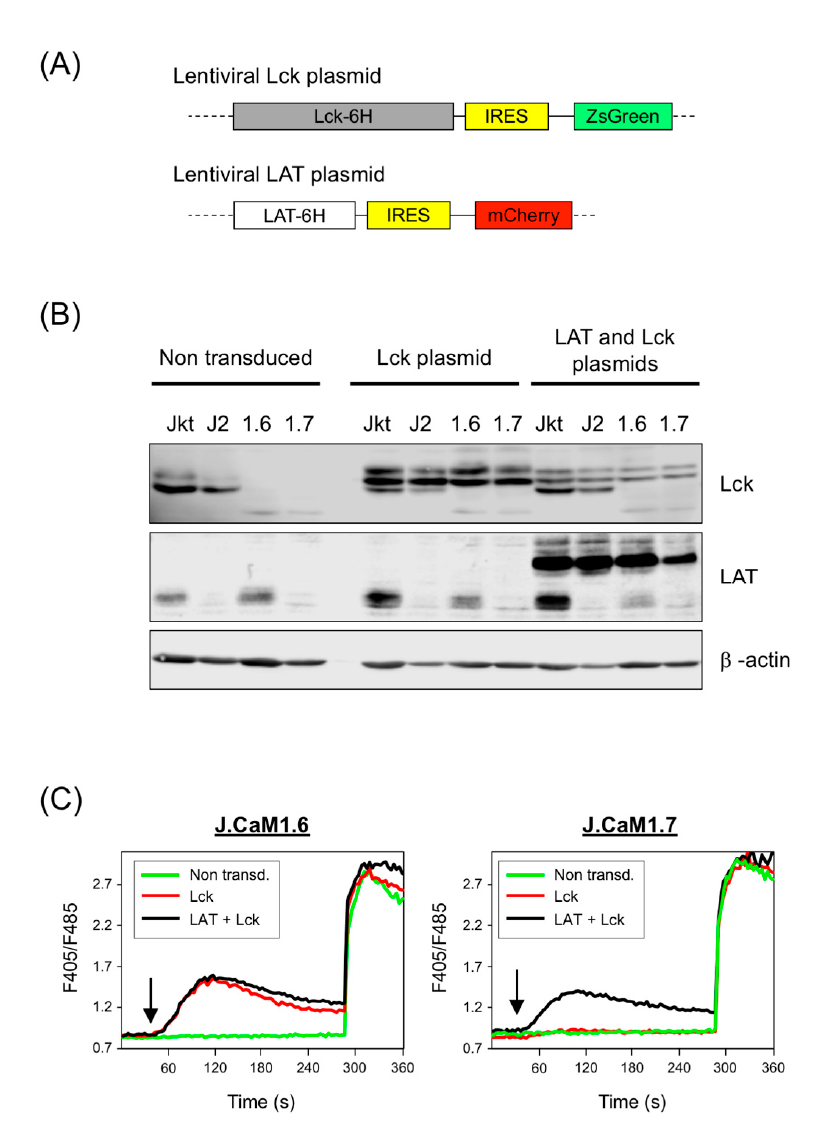
Figure 6B, transduction of J.CaM1.6 and J.CaM1.7 cells with the Lck plasmid reconstituted the expression of this tyrosine kinase, and double transduction with LAT and Lck plasmids recovered LAT and Lck expression in J.CaM1.7 cells.